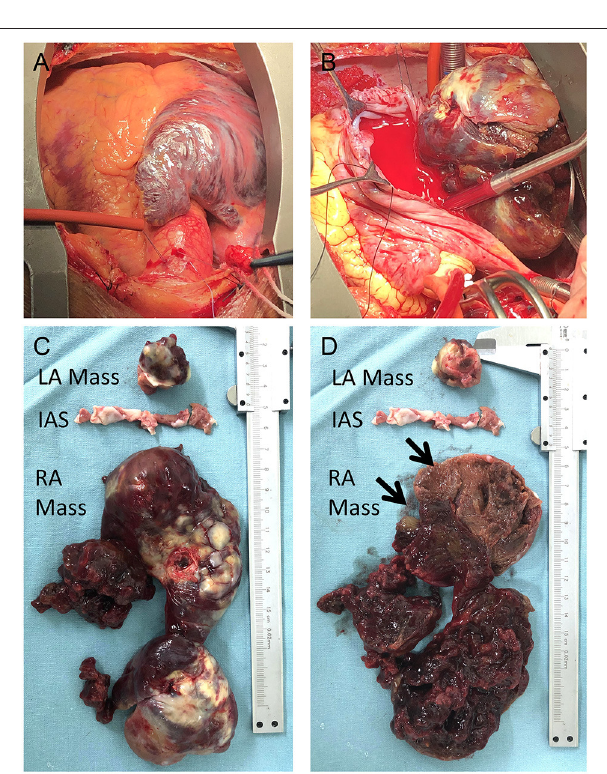
FIGURE 3 | Intraoperative view of the tumor: right atrium was enlarged (A) with the tumor inside the chamber; The right side of the tumor was visualized with the opening of the right atrium (B) ; the biatrial mass together with the infiltrated septum was resected (C,D) ; the right atrial lesion was grossly composed of two parts ( D ,